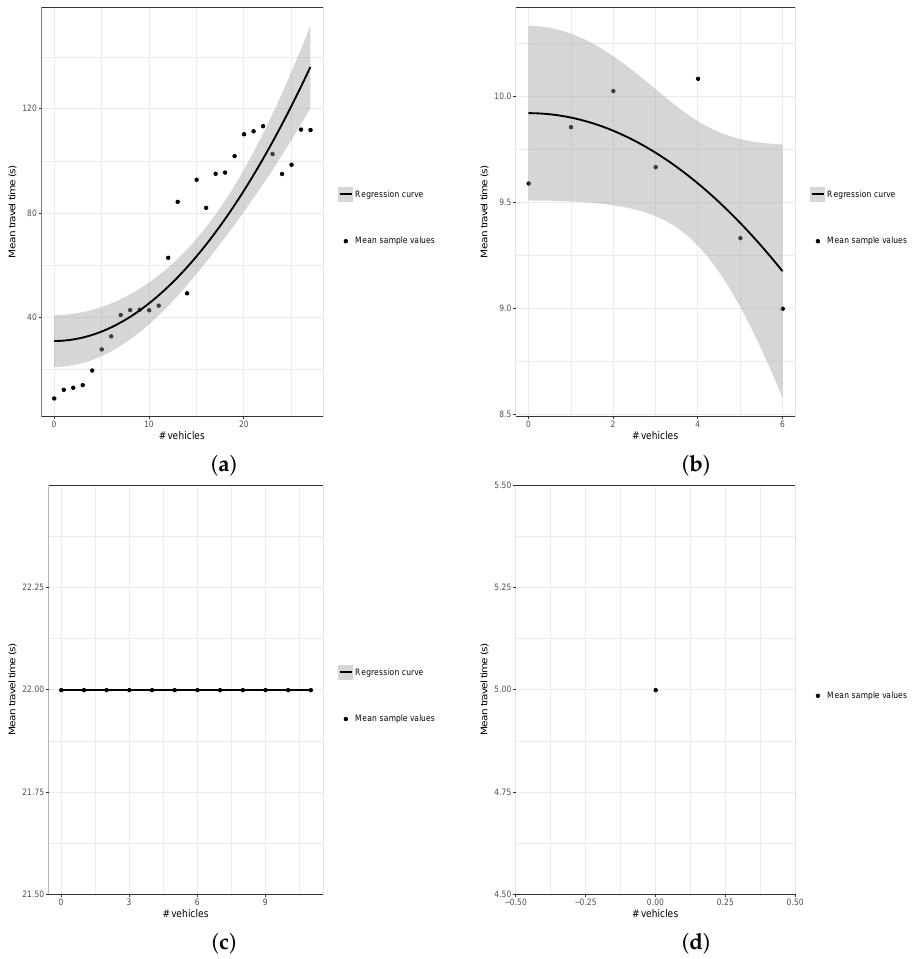
Figure 3. Segment Classification: ( a ) increasing; ( b ) decreasing; ( c ) constant; and ( d )